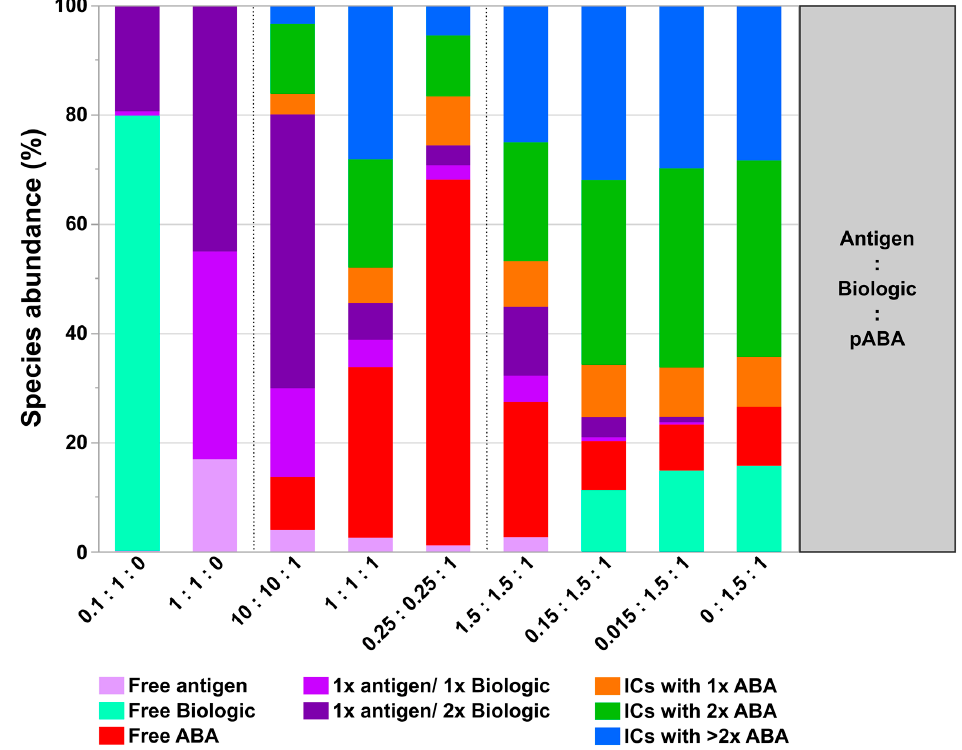
Figure 13. Quantitative SEC-MALS analysis read-out assessing relative levels of formed complexes between antigen, biologic and pABA in PBS background. Analyzed mixtures contain indicated molar ratios between the